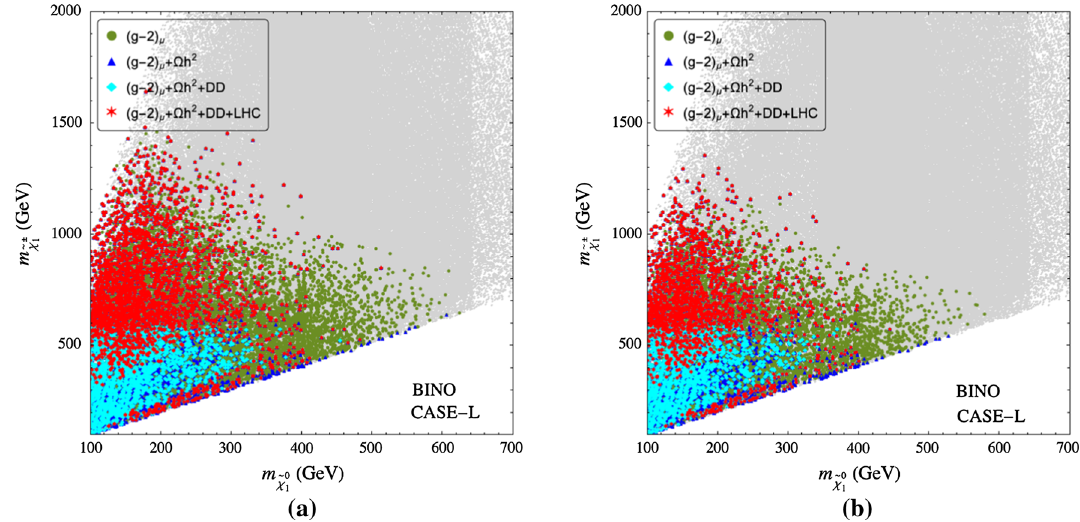
− m plane for the ˜ l -coannihilation case-L scenario for current (left) and anticipated future ˜ χ ± 1 1